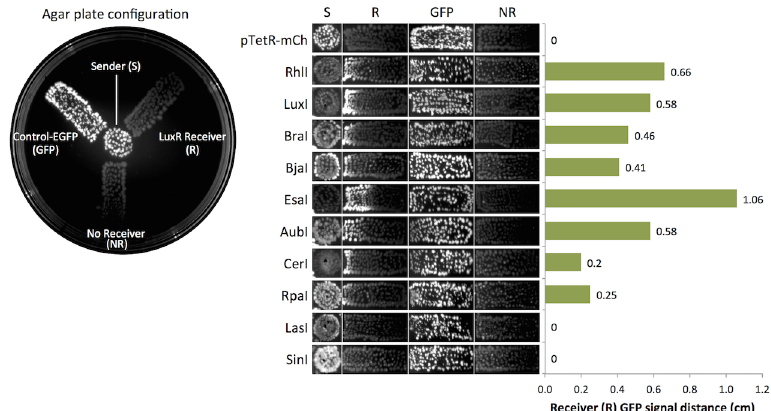
Fig 5. LuxR induction in solid agar cultures. The leftmost image shows the layout used to determine induction distance across agar. Sender bacteria were spotted in the center. Bacteria transformed with Control-EGFP (GFP), receiver negative (NR), or LuxR receiver (R) plasmids were spotted within rectangular areas that radiated away from the center. Induction distance in centimeters is shown for each of the ten Senders